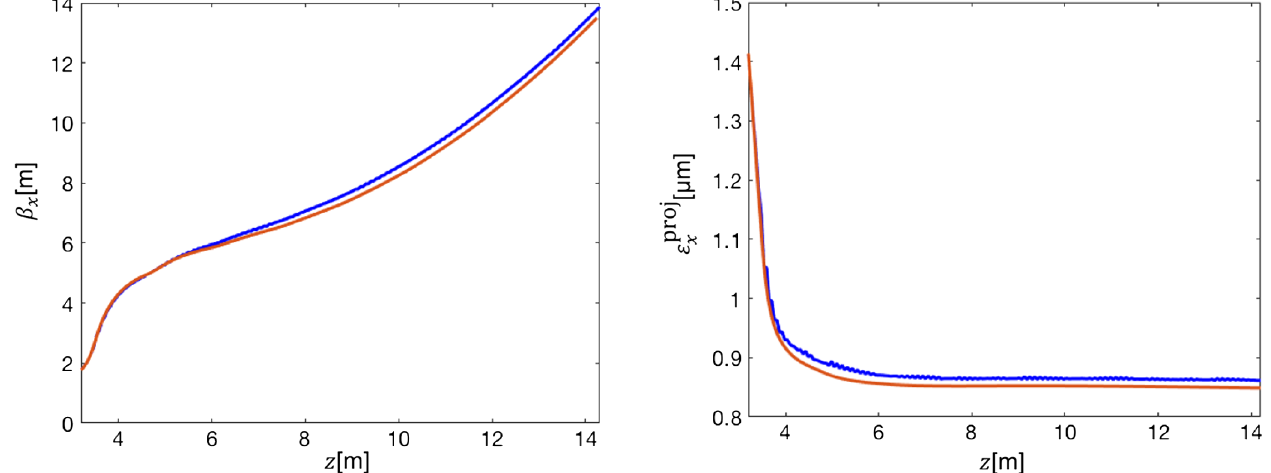
FIG. 12. Comparison of the β function and projected emittance in the booster calculated by ASTRA (in blue) and O celot (in red).